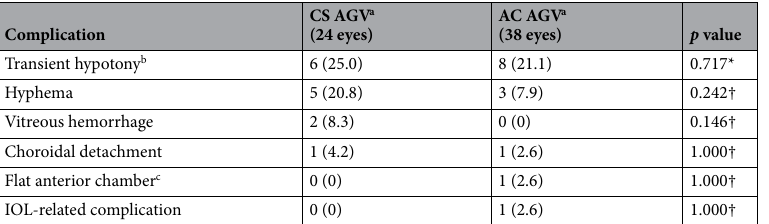
Table 3. Postoperative complications after ciliary sulcus and anterior chamber Ahmed glaucoma valve procedures. Values are presented as the number of cases (percentage). CS AGV ciliary sulcus Ahmed glaucoma valve, AC AGV anterior chamber Ahmed glaucoma valve, IOL intraocular lens. * χ 2 test; †Fisher’s exact test. a Data presented as number of patients (percentage). b Defined as intraocular pressure ≤ 5 mmHg. c Requiring viscoelastic injection into the anterior chamber.